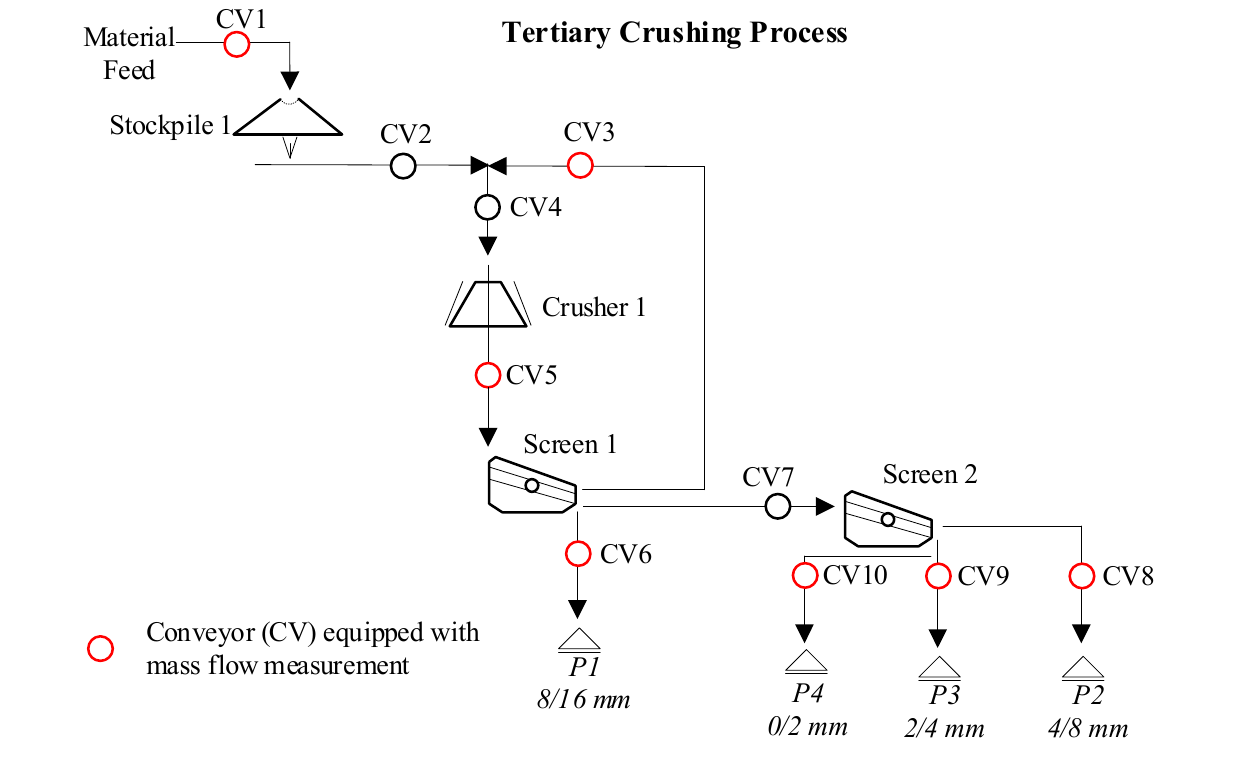
Figure 6. Tertiary crushing process for an industrial-scale aggregate production plant.